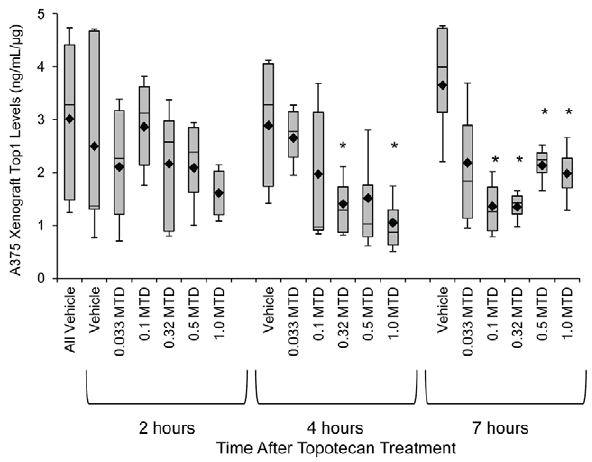
Figure 3. Dose-dependent decrease in Top1 levels in A375 xenografts. Tumor biopsies were collected from A375 xenografts 2, 4, and 7 hours after a single dose of 0.033 to 1.0 MTD topotecan or water vehicle control (n=4/cohort). Box plots represent interquartile range, 10 th and 90 th percentile whiskers, and median Top1 levels; diamonds represent group mean. Asterisks (*), treatment cohort mean was statistically different from vehicle mean at same time point, with a significance level of P # 0.05, as determined by Student’s one-tailed t